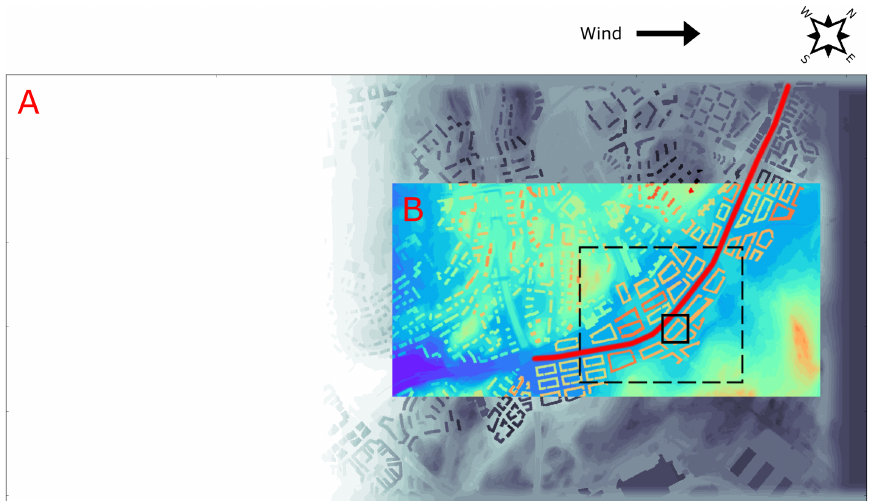
Figure 2. The computational domain for southwesterly ( WD = 225 ◦ ) inflow conditions and V par where the longer sides of building blocks are parallel to the boulevard. The domain is separated into child ( B ) and parent ( A ) domains, where the white colour stands for the topography elevation Z = 0 m. The data output domains are marked with rectangles: the small domain with a solid black and the large domain with a black dashed line. The boulevard is marked in